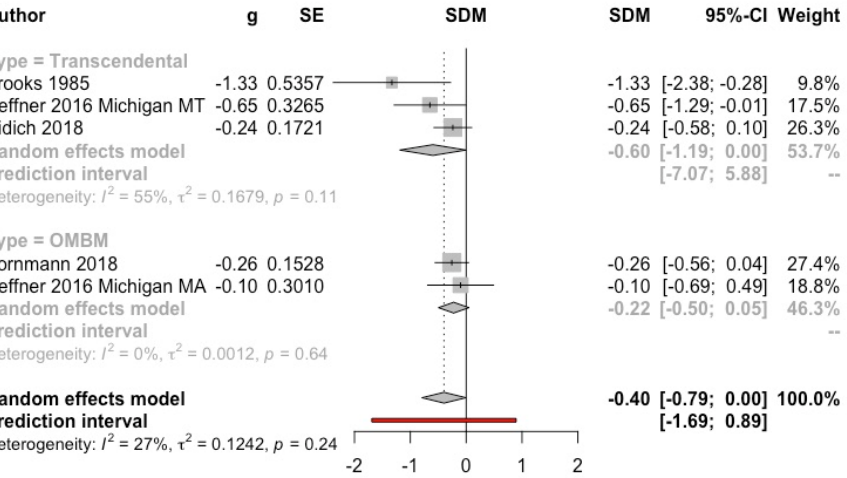
Figure 9. Effect on post-traumatic stress disorder symptoms (meditation vs. psychotherapy). Predictive intervals are represented in red.